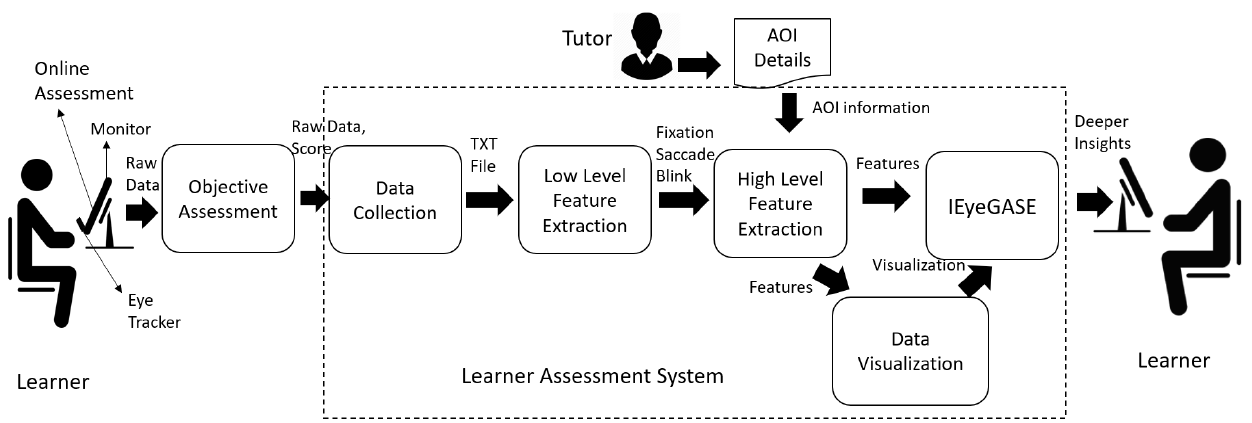
Figure 1. Learner Assessment